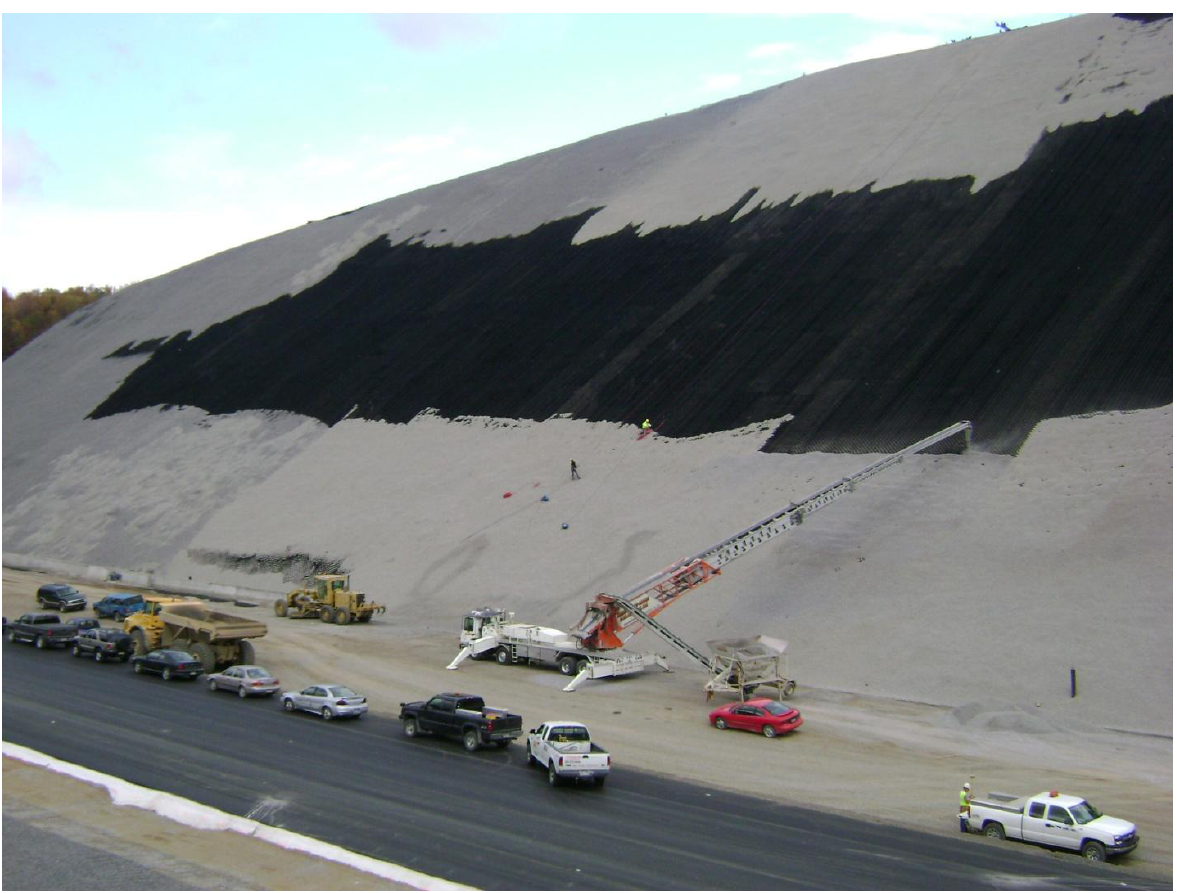
Figure 11. Photo showing stone aggregate infill in progress on the Large Cut